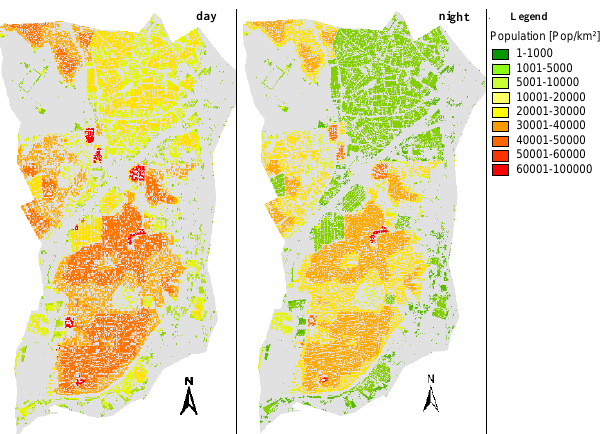
Fig. 5. Dynamic population distribution on individual building level, mega city Istanbul, Turkey